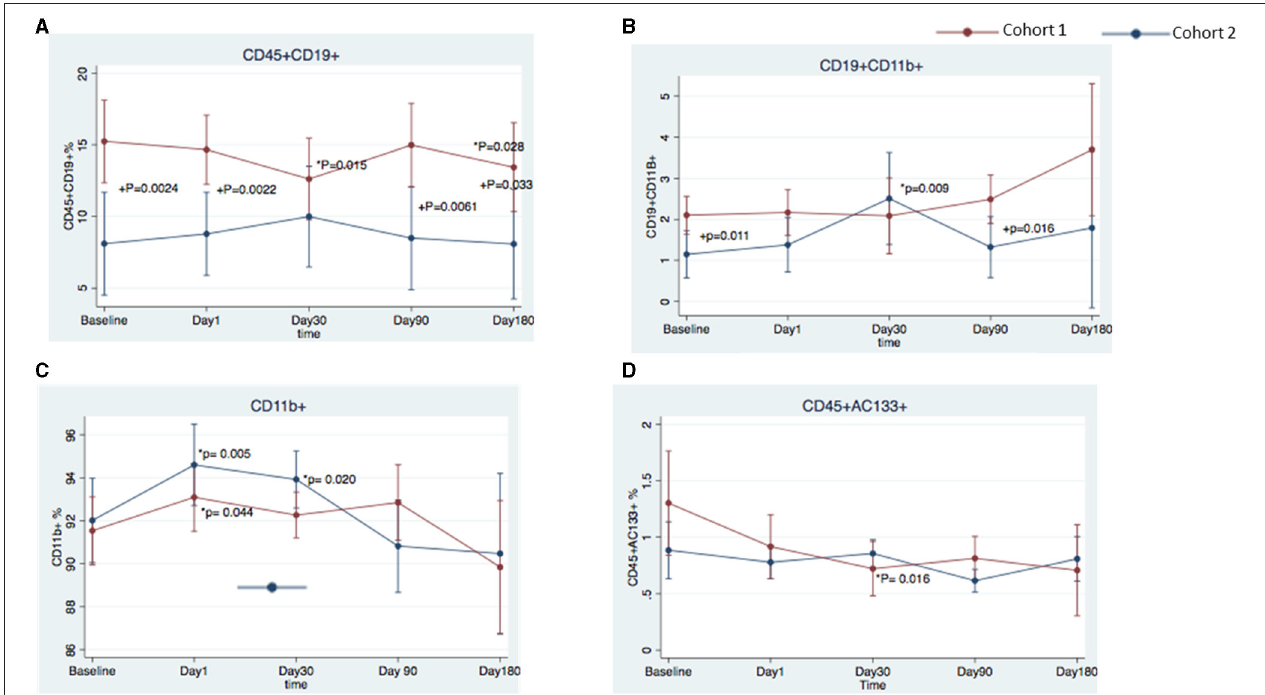
FIGURE 4 | Temporal changes in peripheral blood cell populations in cohort 1 and cohort 2 from the FOCUS-CCTRN trial. Temporal changes in peripheral blood CD45 + CD19 + cells (A) , CD19 + CD11B + cells (B) , CD11B + cells (C) , and CD45 + CD133 + cells (D) . * P = changes over time vs. baseline, + P = cohort 1 vs. cohort 2.